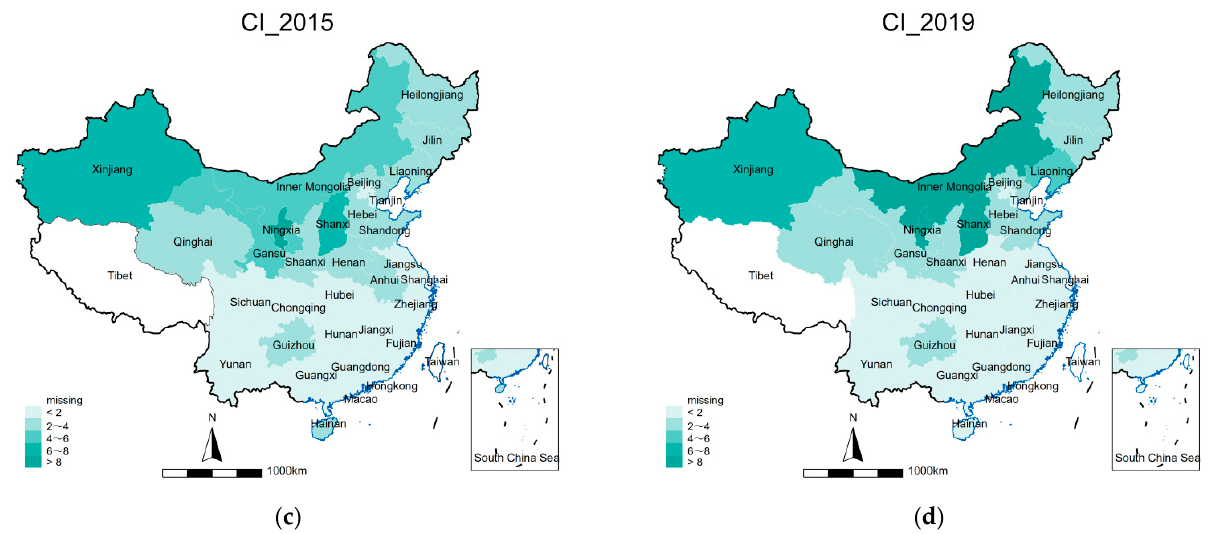
Figure 3. ( a – d ) Geographical distribution of provincial carbon intensity in 2006, 2010, 2015, and